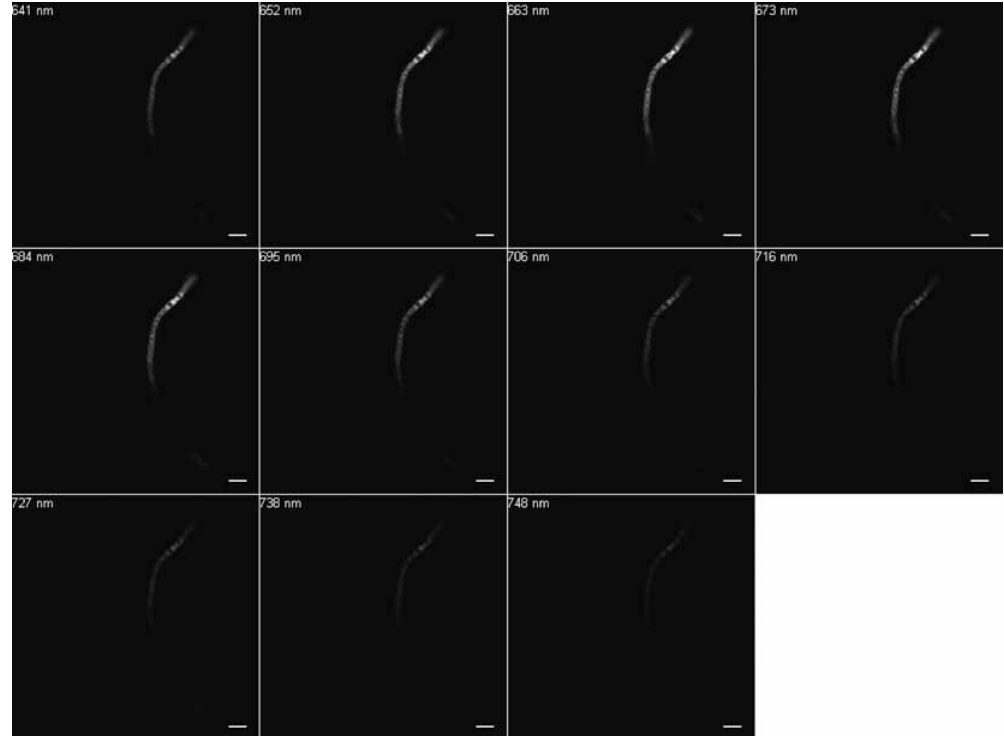
Figure 8. Spectral emission collection of SF33 RL-grown cells after excitation with 633-nm laser. An emission spectrum was gathered at 10.7-nm increments in the range from 640 nm to 750 nm. All images at 63× oil objective. Bars, 10